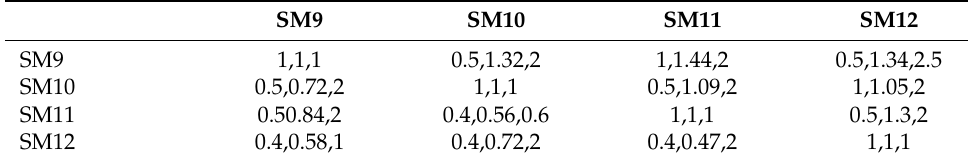
Table 16. FPCM for Social